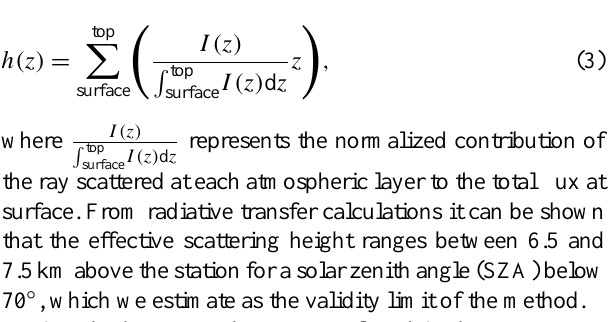
Figure 1. Measured O 4 slant column density versus modeled O 4 for a pure Rayleigh atmosphere at the 477nm band by using cross sections at 203 and 293K temperatures (see text for